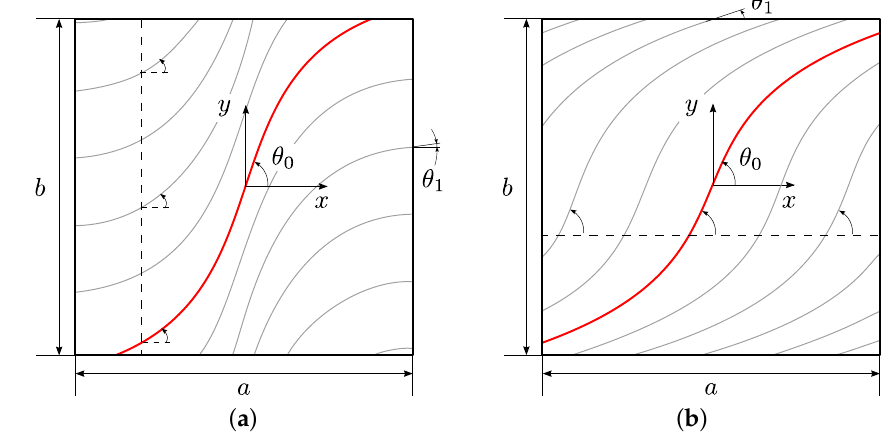
Figure 1. Panel geometry and reference system: ( a ) fiber variation along the x -direction; ( b ) fiber variation along the y